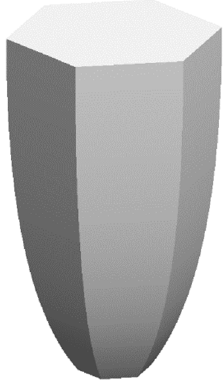
Figure 3. The principle behind the CPC, ( a ) definition of the half-acceptance angle, ( b ) incident angle smaller than the half-acceptance angle, ( c ) incident angle equal to the half-acceptance angle, ( d ) incident angle larger than the half-acceptance angle.